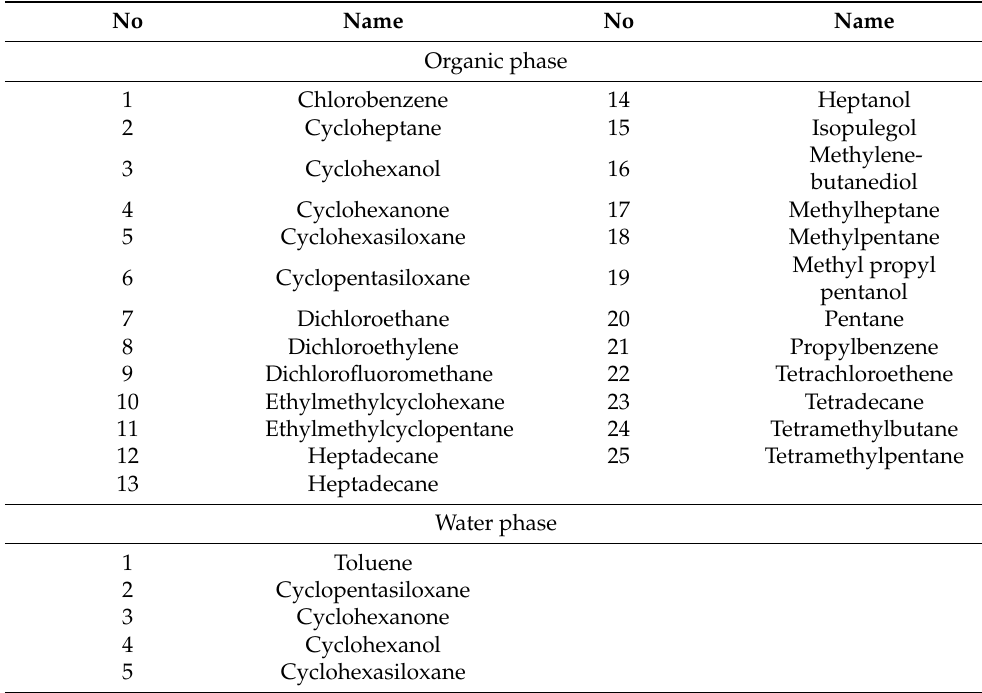
Figure 4. Condensate sample from landfill gas. Table 1. Organic compounds detected by GC-MS in biogas